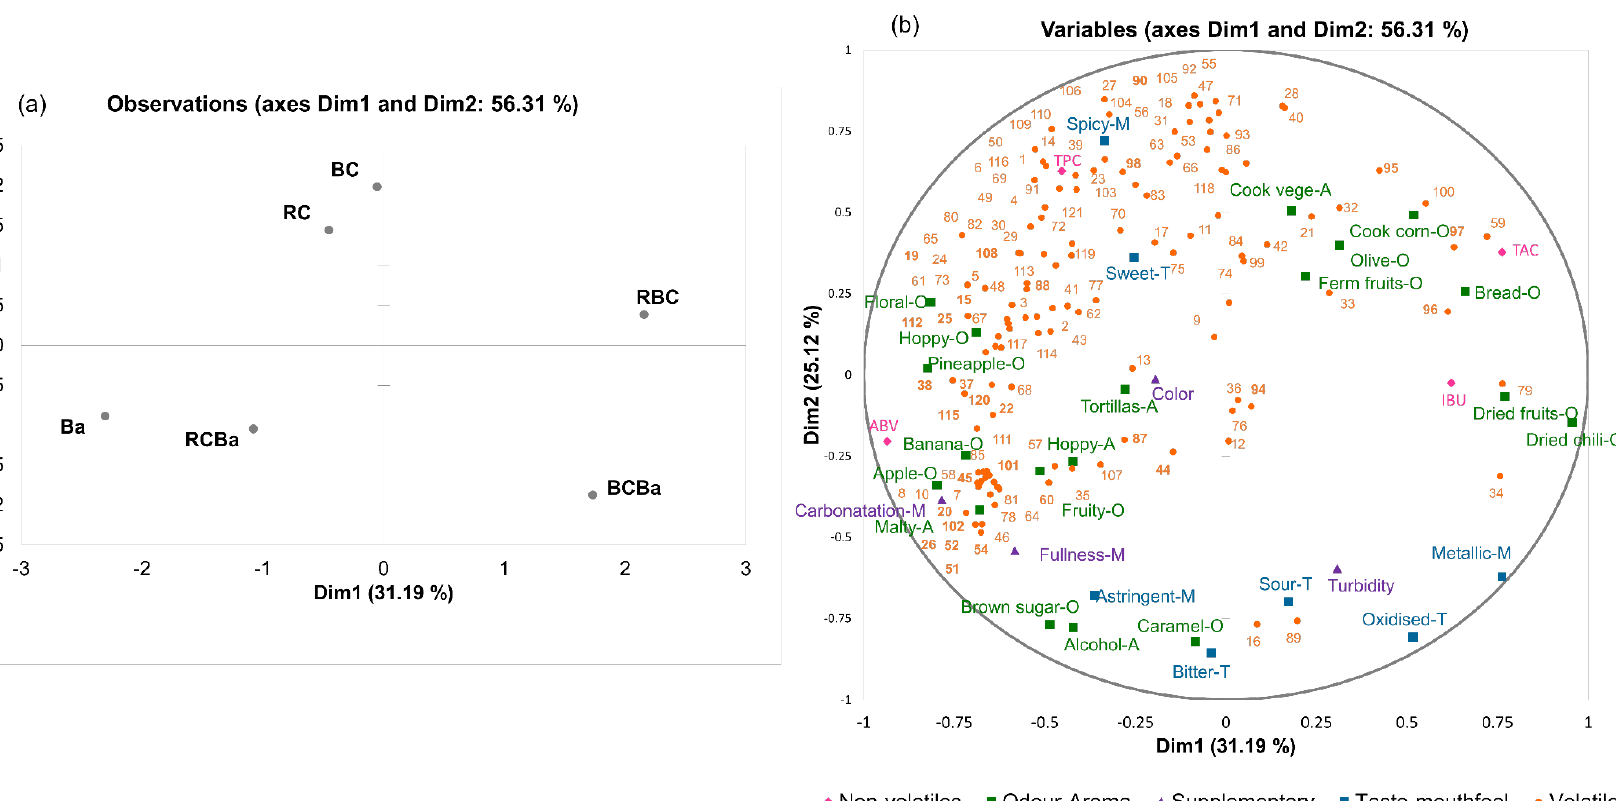
Figure 3. Multiple Factor Analysis (MFA) of descriptive sensory and chemical data of the six beer samples. ( a ) Observations plot of MFA, ( b ) Variables plot of MFA. Numbers correspond to the compounds listened in Table 2. BC = 100% blue corn, RC = 100% red corn, RBC = 50:50 red and blue corn, Ba = 100% barley, BCBa = 50:50 blue corn and barley, RCBa = 50:50 red corn and barley .